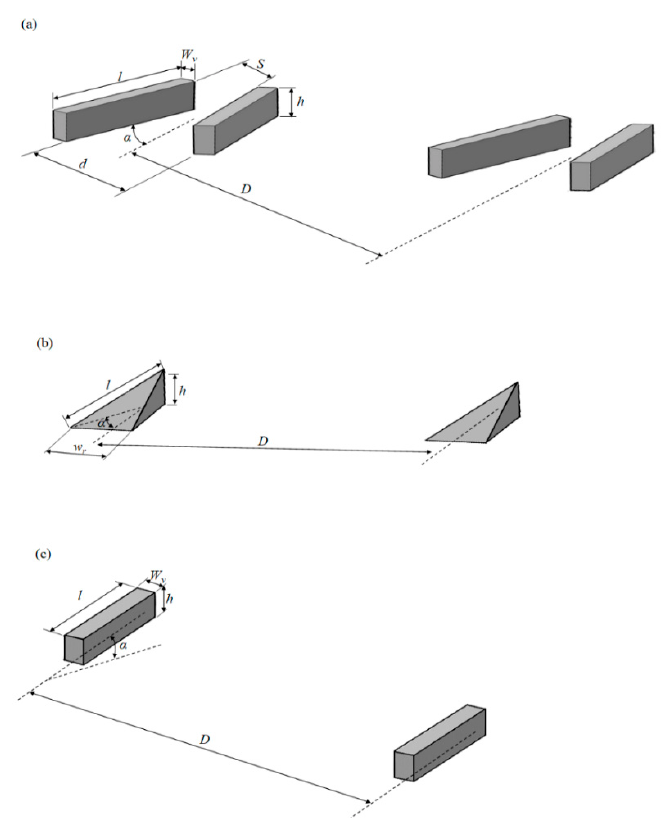
Figure 5. Configuration of MVGs: ( a ) counter-rotating vane type, ( b ) ramp type and ( c ) co-rotating vane type.